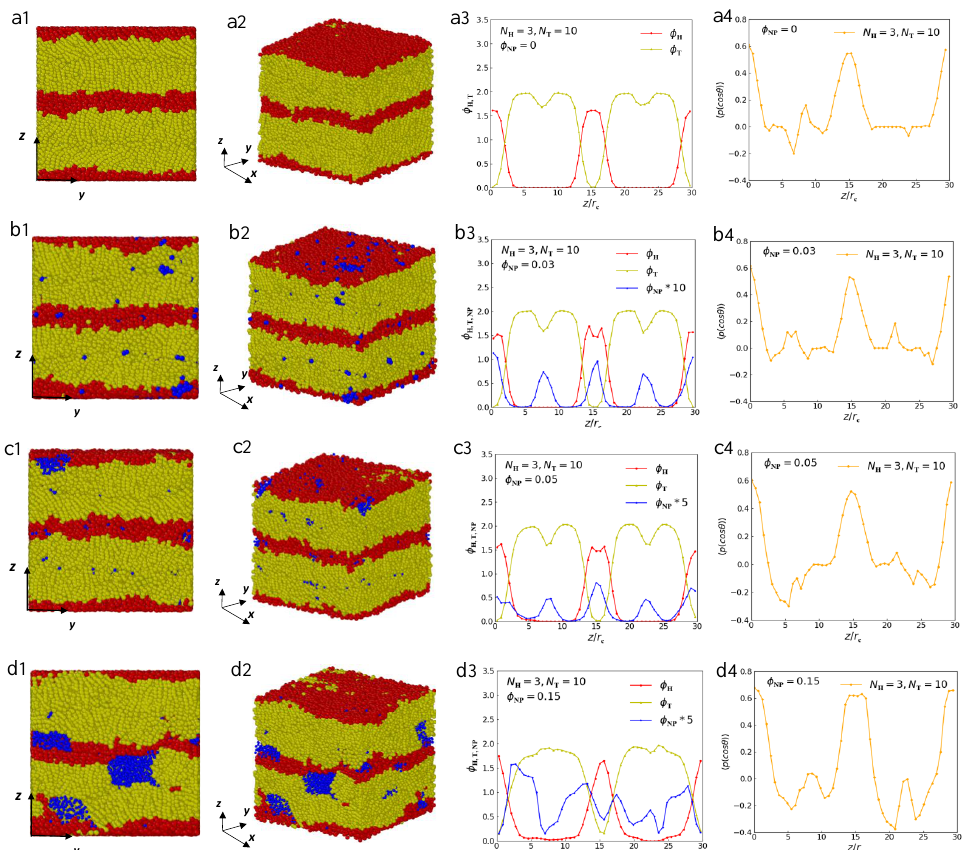
Figure 3. Representative lamellar microstructures of lipid–nanoparticle mixtures with N H = 3 and N T = 10. The microstructures for different views, density profiles and order parameter profiles are listed on the left side, middle and rightmost side, respectively. ( a1 ) The front view of pure lipid molecule with φ NP = 0. ( a2 ) The side view of pure lipid molecule. ( a3 ) The density distribution of pure lipid molecule along the z direction. ( a4 ) Order parameter profile of pure lipid molecule. ( b1 ) The front view of lipid–nanoparticle mixtures with φ NP = 0.03. ( b2 ) The side view of lipid– nanoparticle mixtures with φ NP = 0.03. ( b3 ) The density distribution of lipid–nanoparticle mixtures with φ NP = 0.03 along the z direction. ( b4 ) Order parameter profile of lipid–nanoparticle mixtures with φ NP = 0.03. ( c1 ) The front view of lipid–nanoparticle mixtures with φ NP = 0.05. ( c2 ) The side view of lipid–nanoparticle mixtures with φ NP = 0.05. ( c3 ) The density distribution of lipid– nanoparticle mixtures with φ NP = 0.05 along the z direction. ( c4 ) Order parameter profile of lipid–nanoparticle mixtures with φ NP = 0.05. ( d1 ) The front view of lipid–nanoparticle mixtures with φ NP = 0.15. ( d2 ) The side view of lipid–nanoparticle mixtures with φ NP = 0.15. ( d3 ) The density distribution of lipid–nanoparticle mixtures with φ NP = 0.15 along the z direction. ( d4 ) Order parameter profile of lipid–nanoparticle mixtures with φ NP =